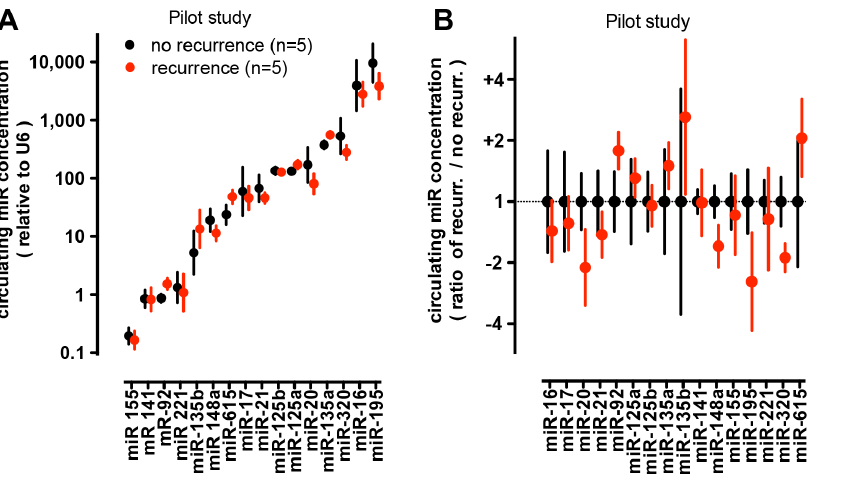
Figure 2. miR expression levels in serum samples from patients with or without recurrence of early stage colon cancer (Pilot Study). Candidate miR approach. Circulating levels of 16 miRs indicated on the x-axis that had been published as differentially expressed between colon cancer and non–malignant colon tissues were analyzed [21,34,35]. Pre-surgery serum samples were from patients in the pilot study. Patients had been followed for disease recurrence and the respective data are in Fig. 1B. A , Concentration of circulating miRs (relative to U6). Note the log-scale that covers a range of 100,000-fold. B , ratio of expression between patient groups. Alhough miR-20, miR-195 and miR-320 showed a $ 2-fold downregulation, and miR-135b and miR-615 a $ 2-fold upregulation in serum from patients with disease recurrence, neither of the comparisons reached statistical significance by ANOVA (p . 0.05).